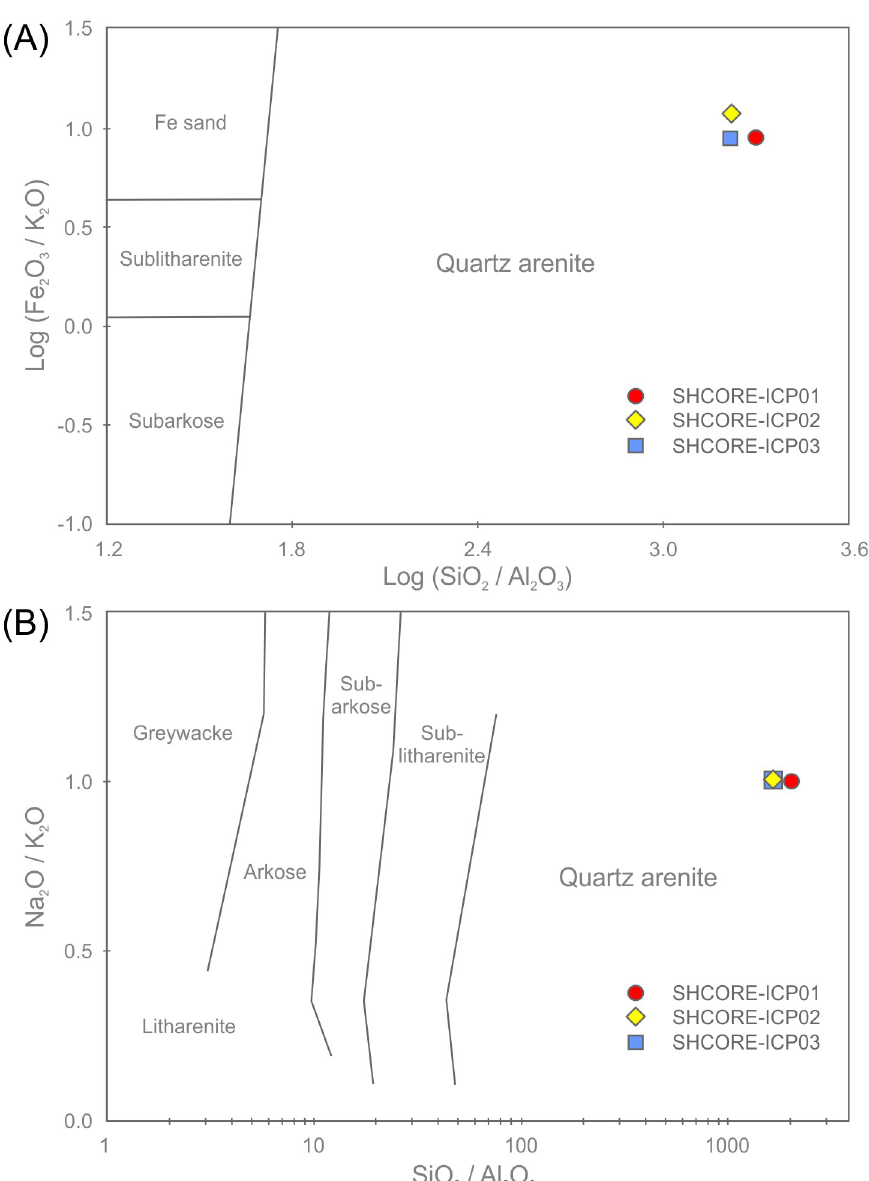
K 2 O, modified after [54]. Na 2 O was below detection limit in SHCORE-ICP02 and K 2 O was below detection limit in all three samples. For plotting, detection limit values (0.01 wt. %) are used for the affected